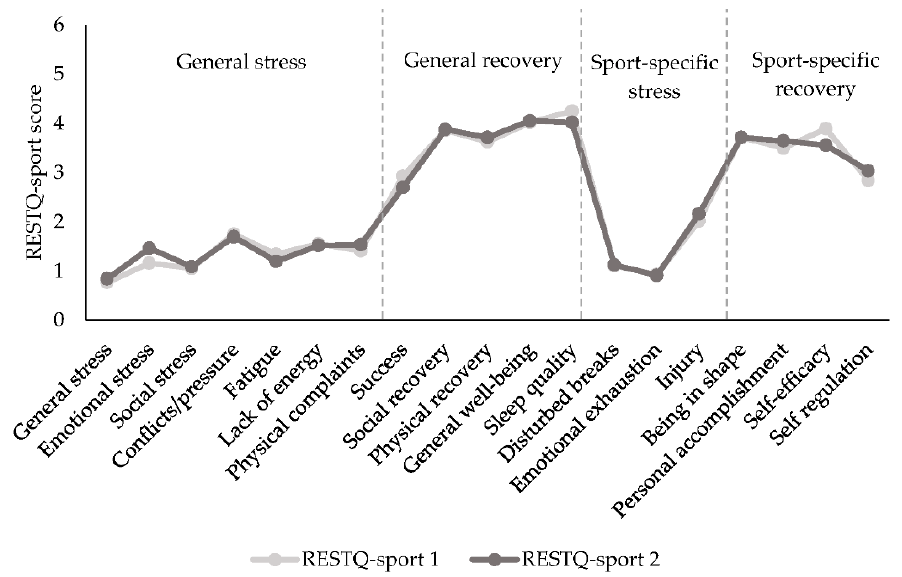
Figure 2. Mean RESTQ-sport scores on the first and second RESTQ-sport measurements. SDs for each subscale range from 0.39 to 1.07. No significant differences were found.